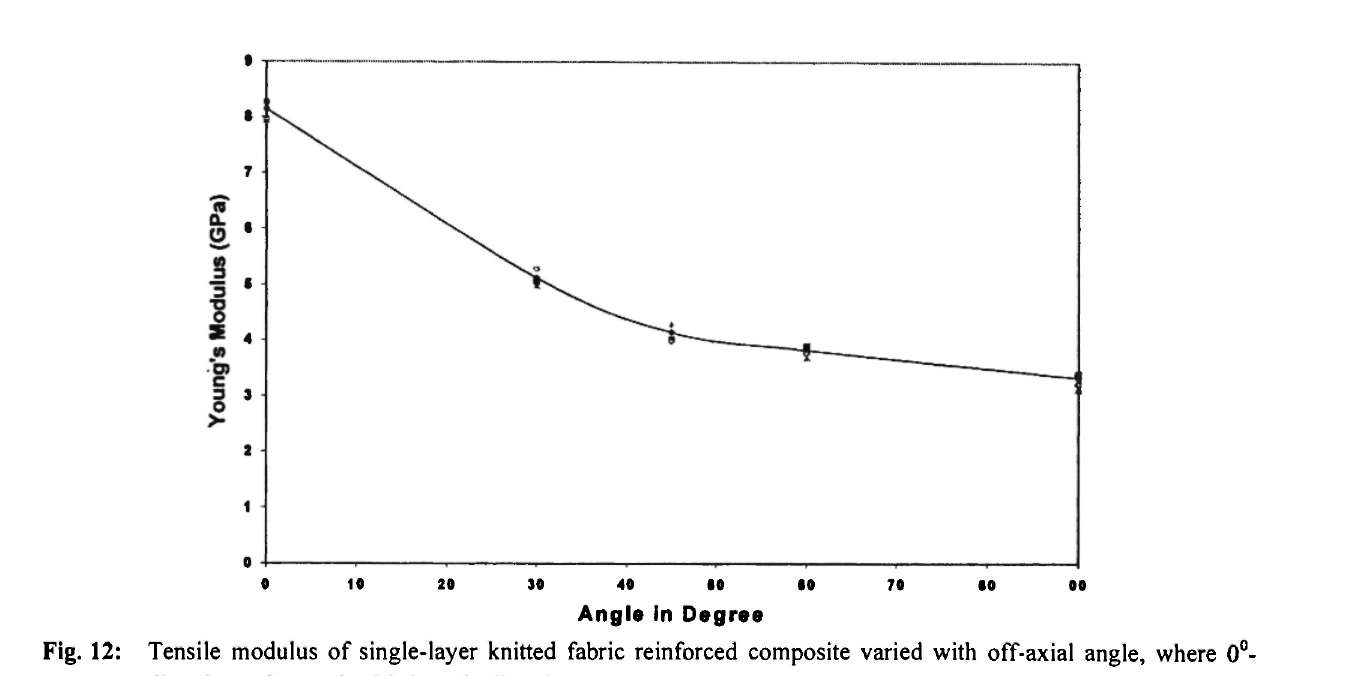
Fig. 12: Tensile modulus of single-layer knitted fabric reinforced composite varied with off-axial angle, where in- direction refers to the fabric wale direction.